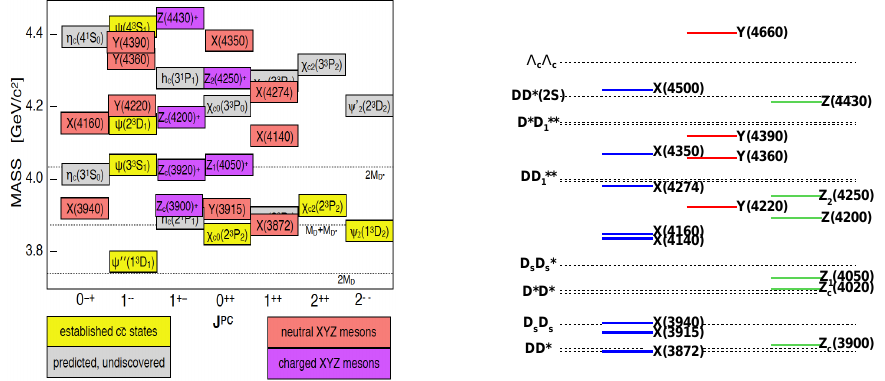
Figure 4. XYZ meson masses compared with charmed meson pair